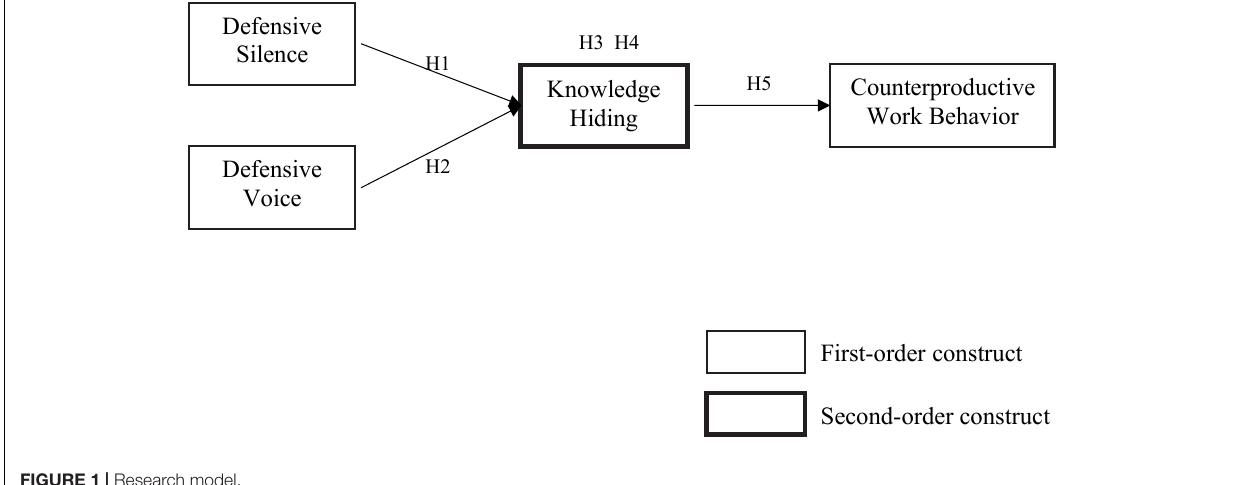
FIGURE 1 | Research